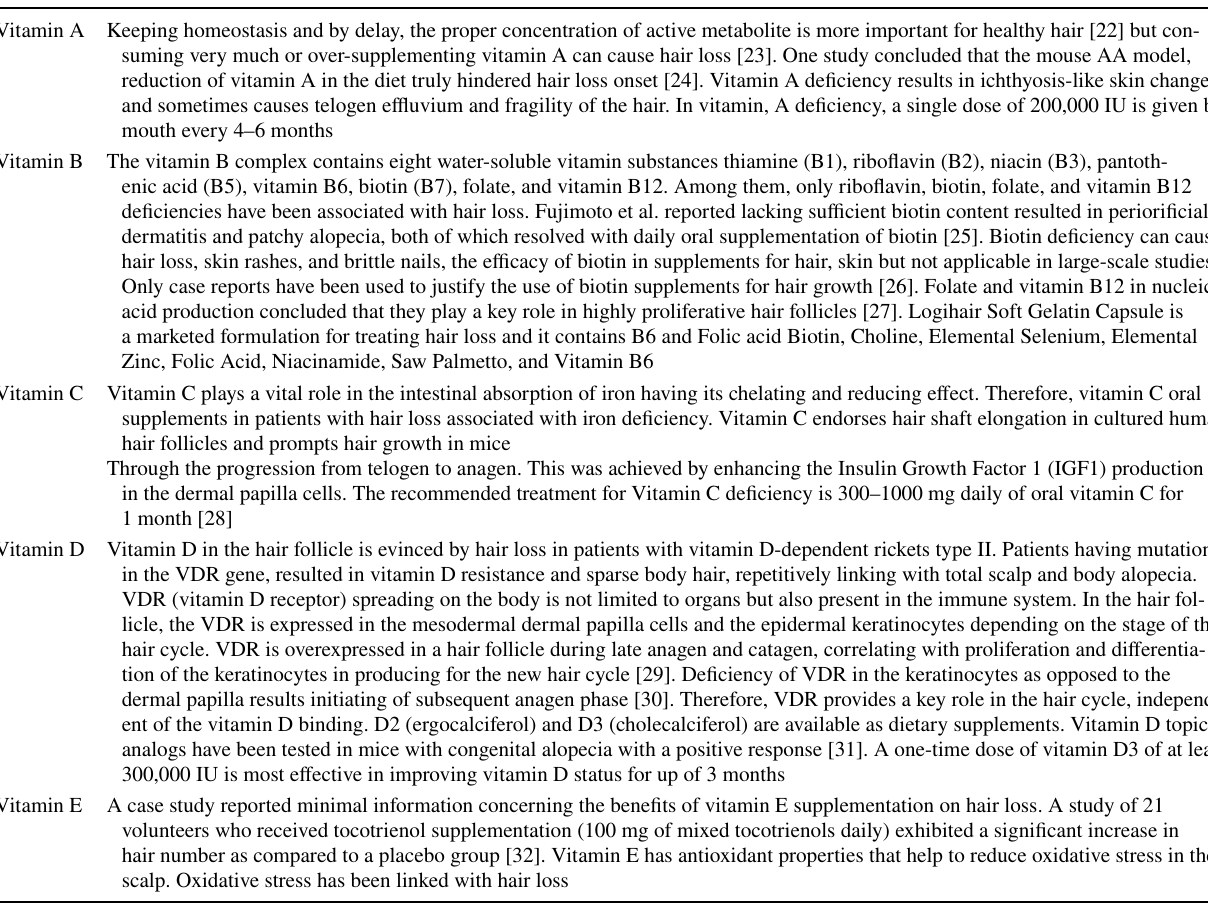
Table 2 Brief elaboration of different vitamins to treat androgenic alopecia Vitamin A Keeping homeostasis and by delay, the proper concentration of active metabolite is more important for healthy hair [22] but con- suming very much or over-supplementing vitamin A can cause hair loss [23]. One study concluded that the mouse AA model, reduction of vitamin A in the diet truly hindered hair loss onset [24]. Vitamin A deficiency results in ichthyosis-like skin changes and sometimes causes telogen effluvium and fragility of the hair. In vitamin, A deficiency, a single dose of 200,000 IU is given by mouth every 4–6